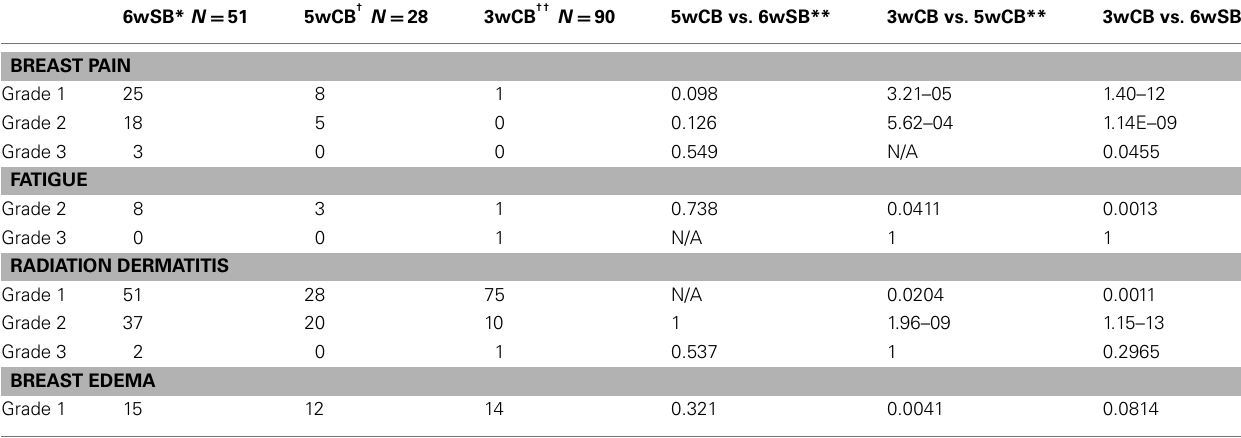
Table 4 | Comparison of acute radiation toxicity among the three